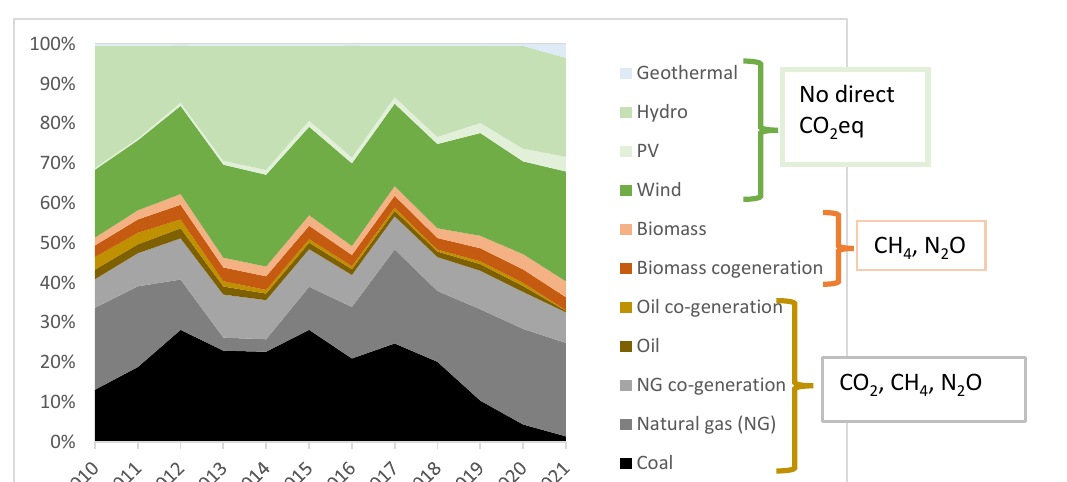
Figure 6. CO 2 eq emission factors according to own simulation, Eurostat ([28]) and APA [27].